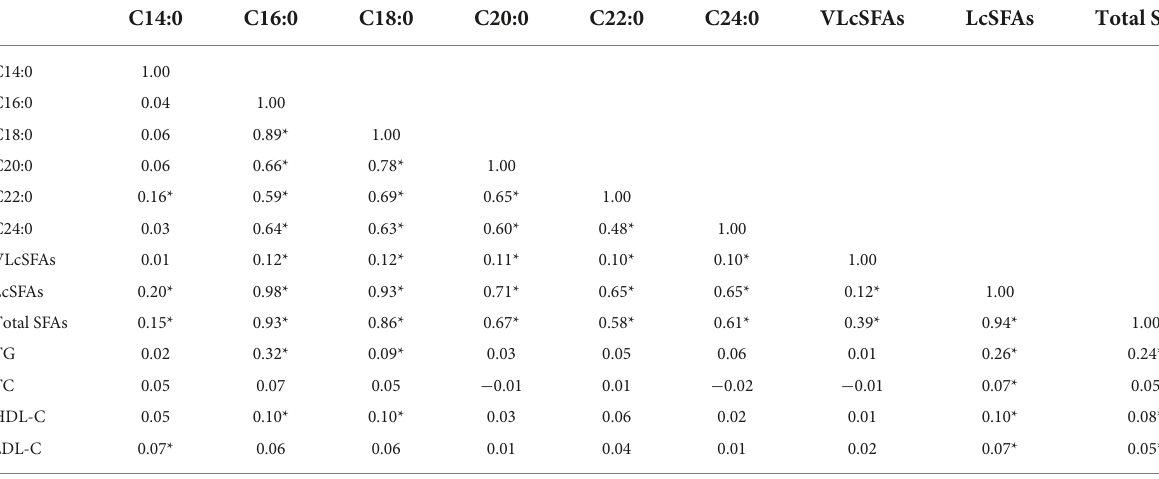
AllFAswerepresentedasabsoluteconcentrationsandPearsoncorrelationcoefficientwereshowed. * p <